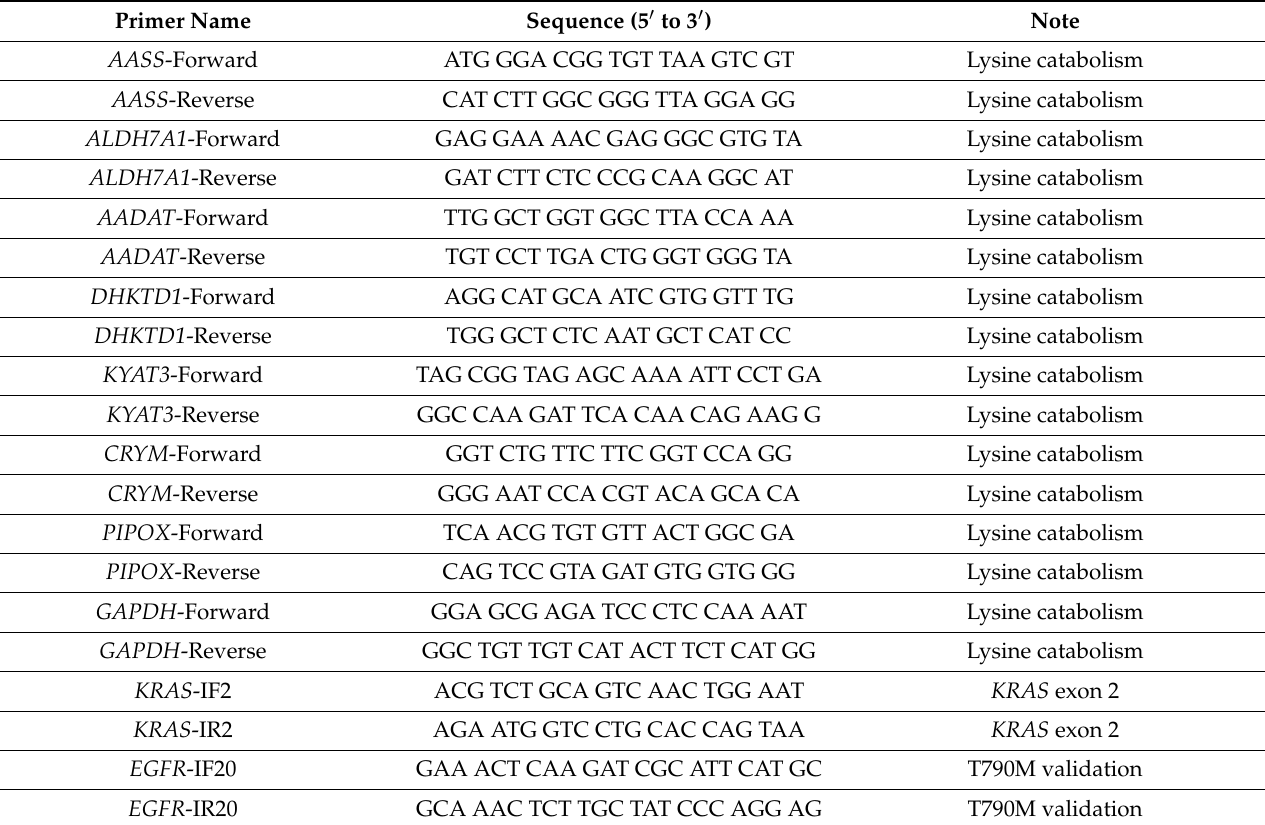
Table A2. The primer sets used in this